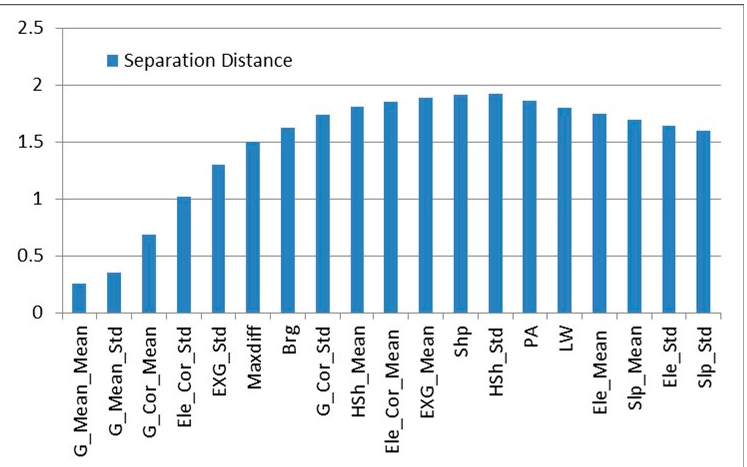
Figure 6. Feature ranking for kNN classification.